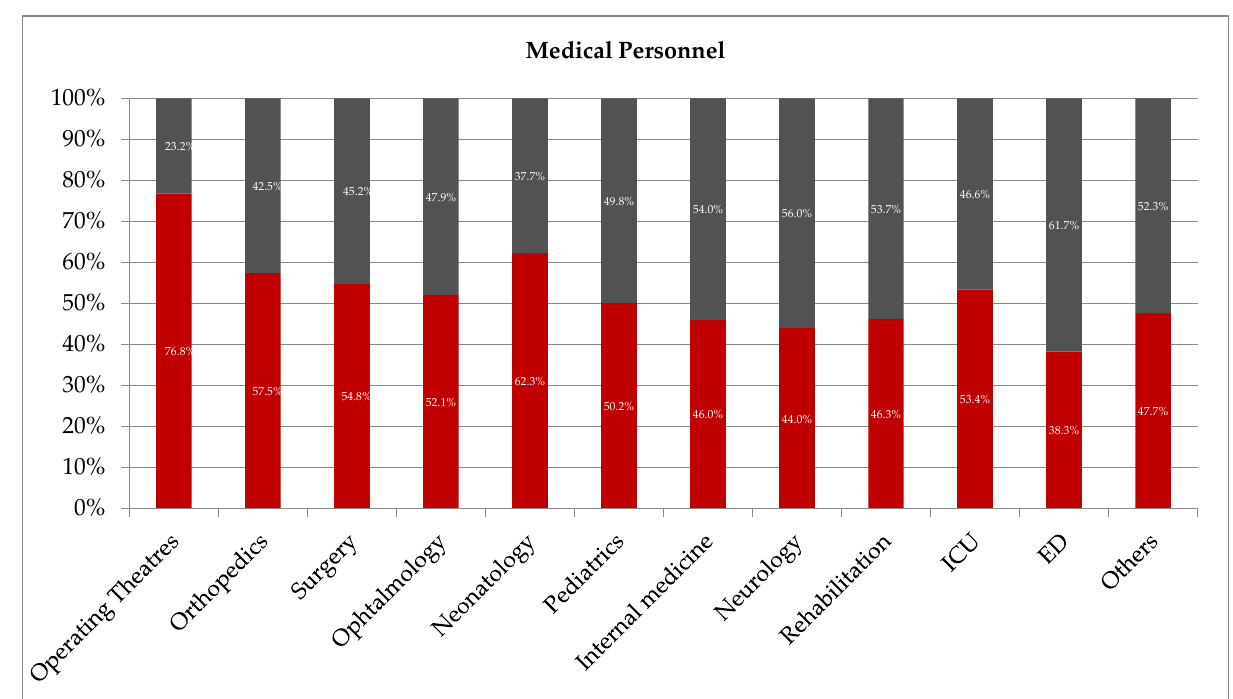
Figure 2. The frequency of compliance with the BBE policy among hospital medical personnel (other — administration, radiology, laboratory, pharmacy; ICU — intensive care unit; ED — emergency department). Black color — non-BBE group; red color — BBE group.